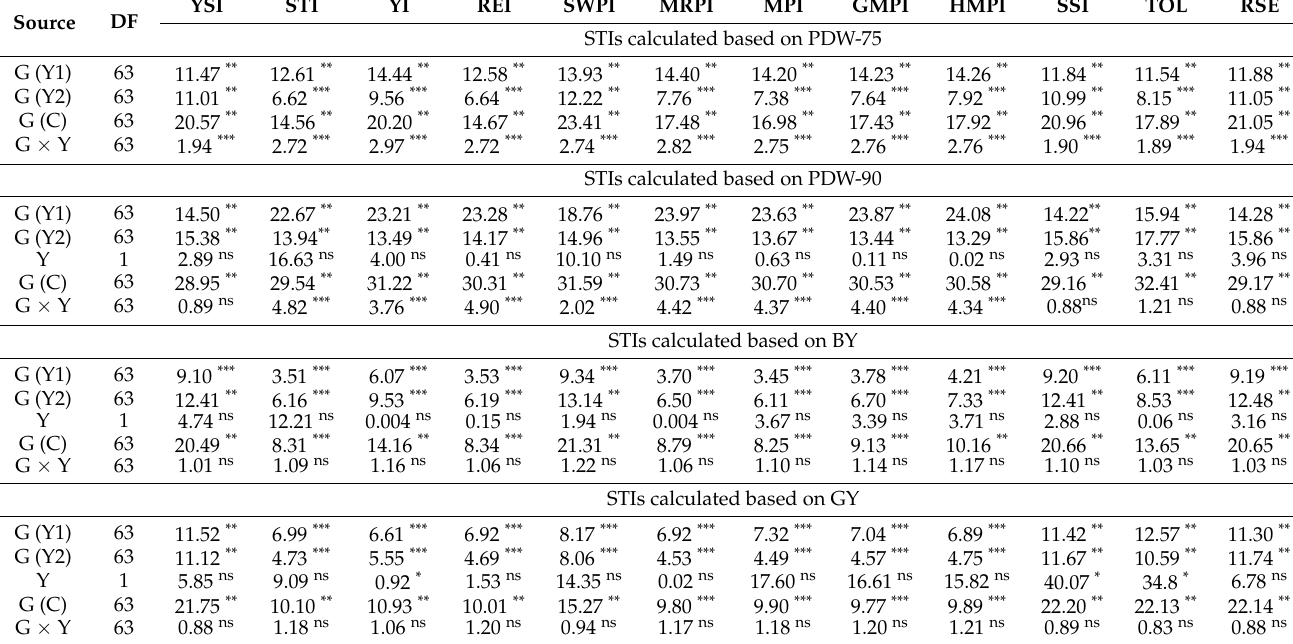
Table 3. Analysis of variance (F-values) for different stress tolerance indices (STIs) calculated based on plant dry weight measured at 75 (PDW-75) and 90 (PDW-90) days after sowing, biological yield (BY), and grain yield (GY) of 64 wheat genotypes for the first year (Y1), second year (Y2), and combined across two years